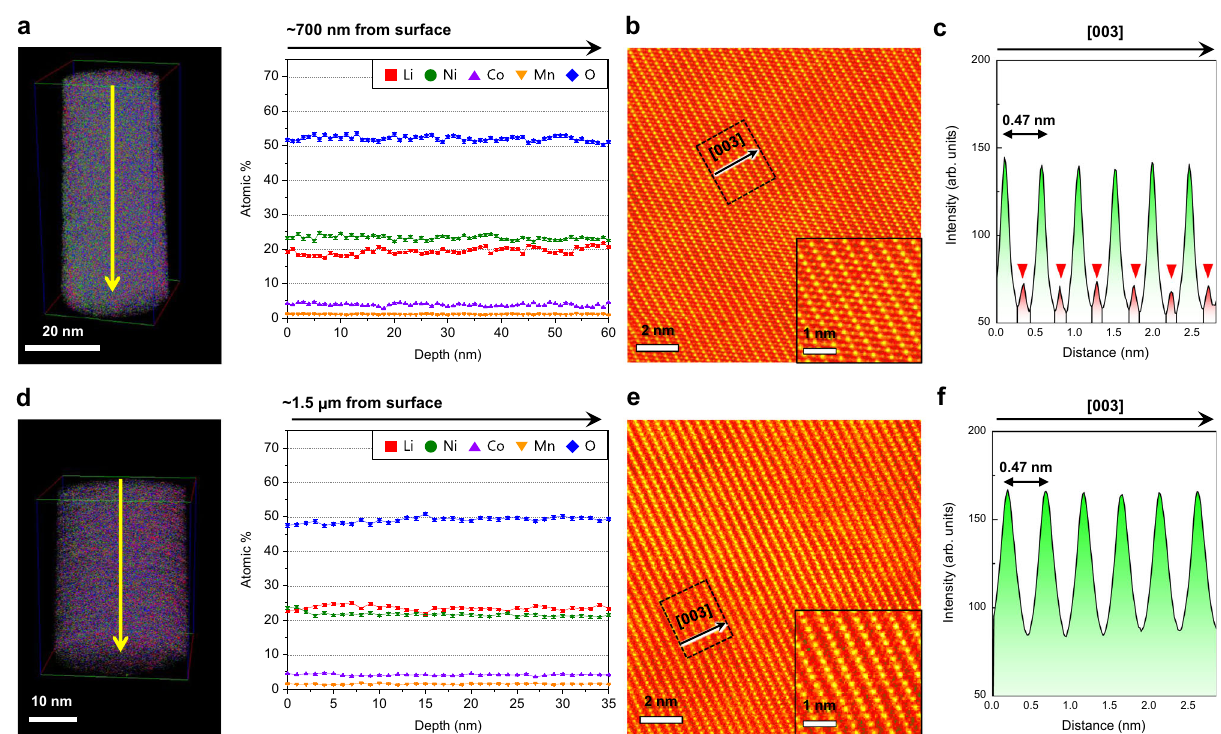
Fig. 4 Mitigation of Li de fi ciency and disordering in the interior of NCM-300 cycles. a APT depth pro fi le at ~700 nm from the top surface, showing slightly de fi cient Li concentration. b , c STEM-HAADF image ( b ) and intensity pro fi le ( c ) sampled at depths of 500 nm – 1 µ m. A partially disordered structure (inset: magni fi ed image) formed owing to the low degree of TM migration to 3a sites (red arrows) d APT depth pro fi le in the central region of the NCM particle, showing the same Li concentration as that of NCM-pristine. e , f STEM-HAADF image ( e ) and intensity pro fi le ( f ) in the central region. Layered structure (inset: magni fi ed image) is well maintained, showing no TM migration. Error bars show the standard deviation of each